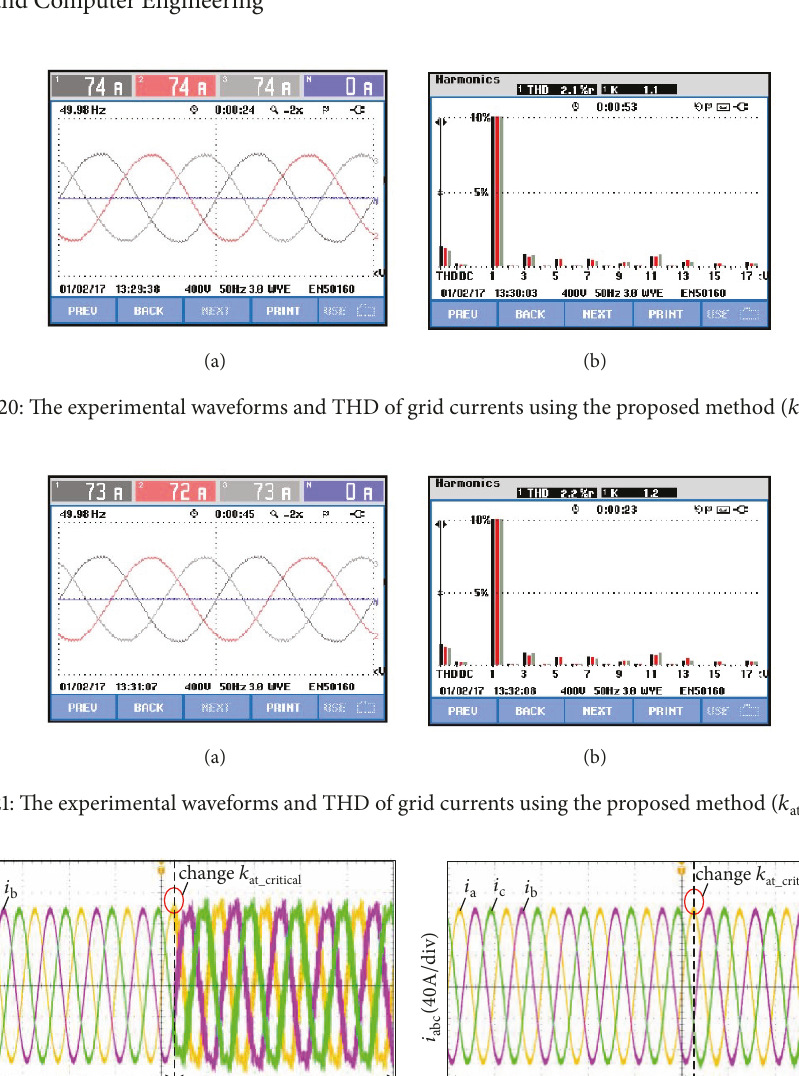
Figure 22: Steady state experimental waveforms of grid currents with the single update PWM and proposed